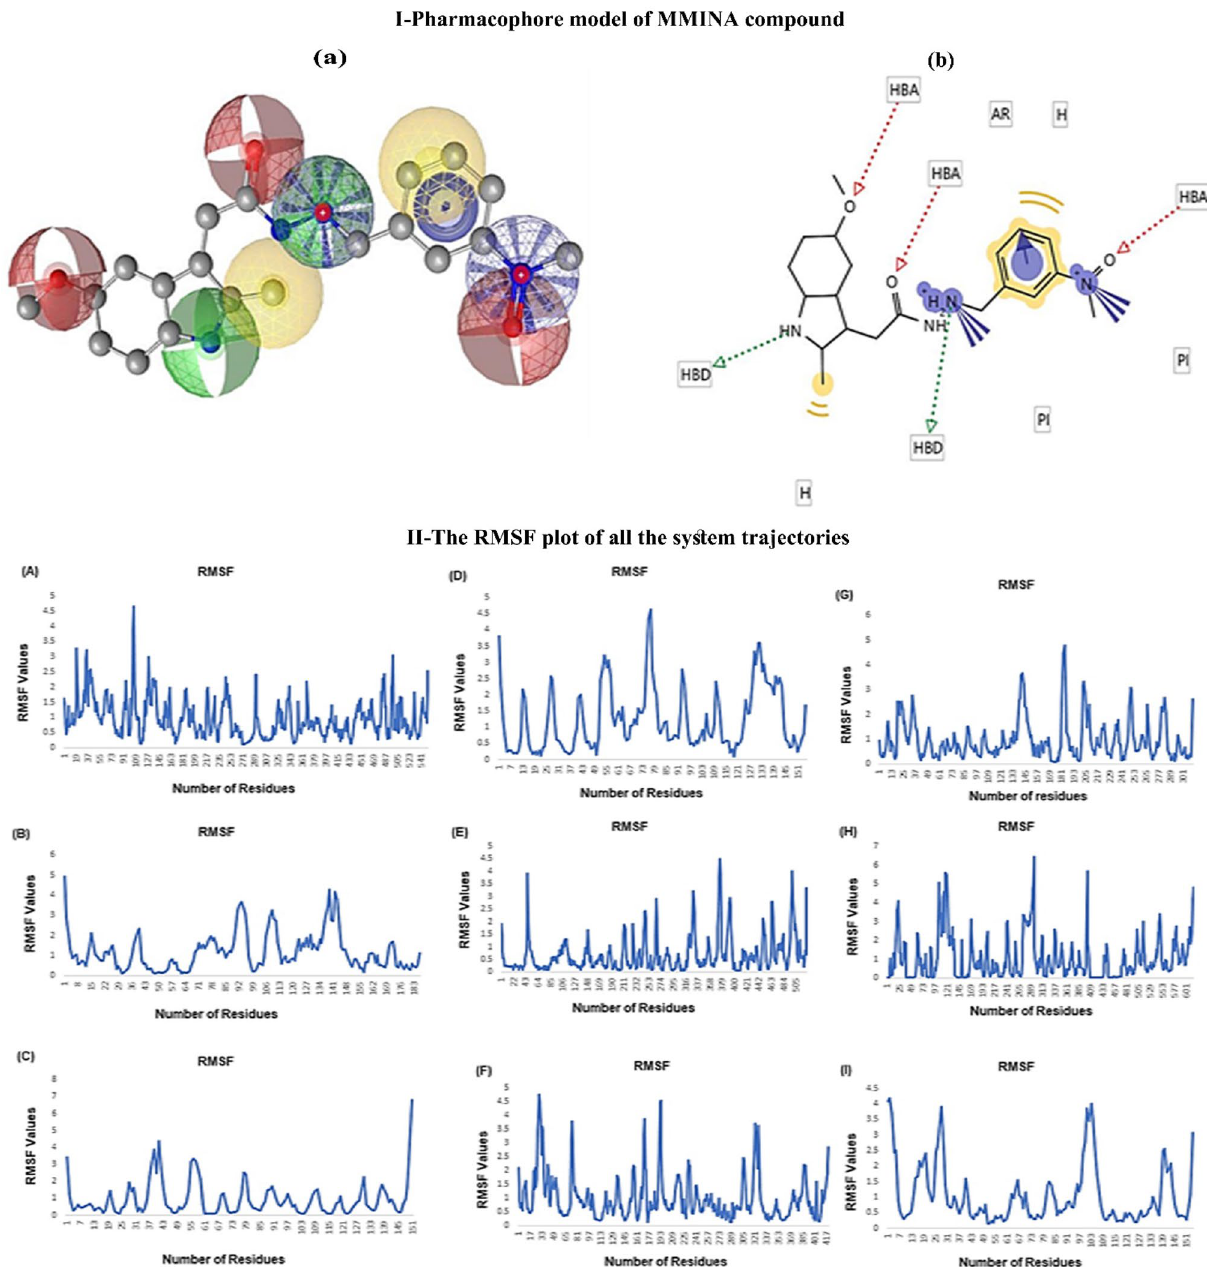
Figure 11. I Pharmacophore model of MMINA compound. ( A ) 3D representation of MMINA pharmacophore model. Red spheres repersents hydrogen bond acceptor (HBA), green spheres showing hydrogen bond donor (HBD) and yellow spheres depicting aromatic rings. ( B ) The same color theme with same descriptors are represented in 2D conformation. II: The RMSF plot of all the system trajectories. ( A ) COX2 ( B ) GPX, ( C ) IL1 ( D ) SOD, ( E ) STAT3, ( F ) iNOS, ( G ) NFKB, ( H ) p65 and ( I )